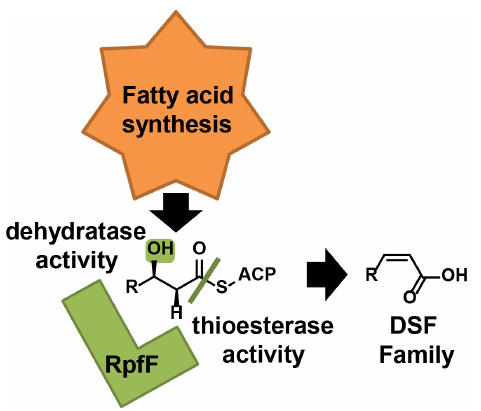
Figure 3. Schematic model for the process of DSF synthesis catalyzed by